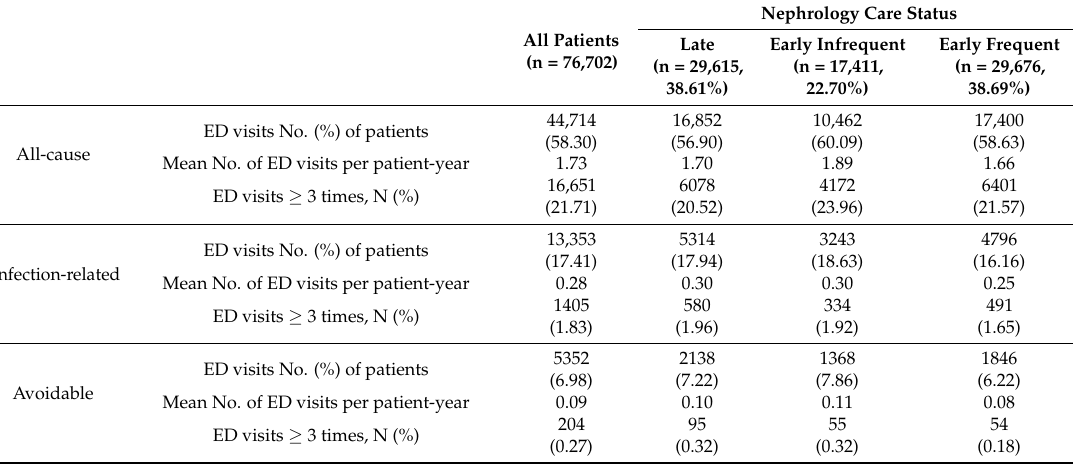
Table 2. Characteristics for ESRD patients and 1-year post-dialysis ED visits.